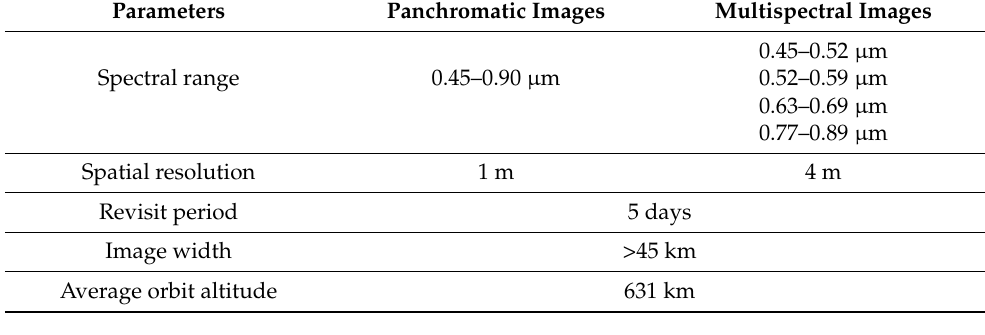
Table 1. Attributes of the GF-2 satellite images.